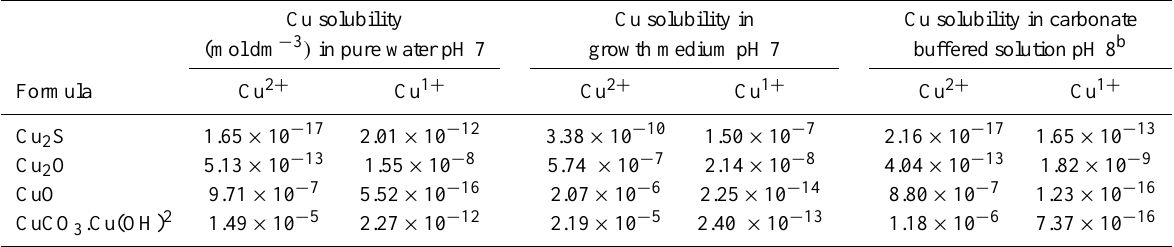
Table 1. Modelled dissolved Cu concentrations for aqueous solutions equilibrated with various Cu mineral phases (25 ◦ C) calculated using the PHREEQC geochemical simulation software (Parkhurst and Appelo, 1999) a